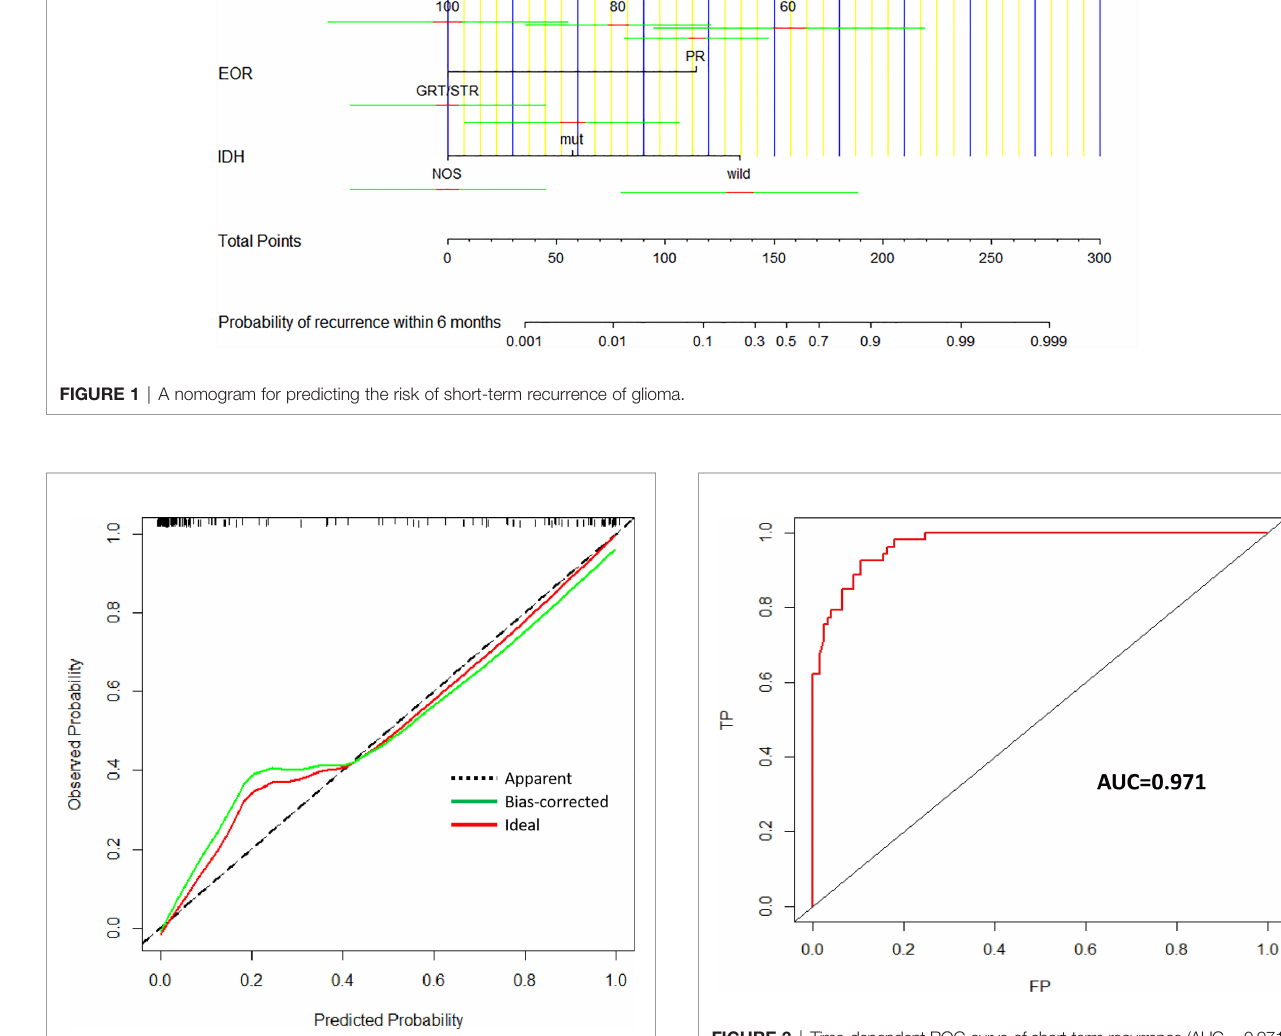
FIGURE 3 | Time-dependent ROC curve of short-term recurrence (AUC = 0.971). ROC, receiver operating characteristic; AUC, area under the ROC curve.